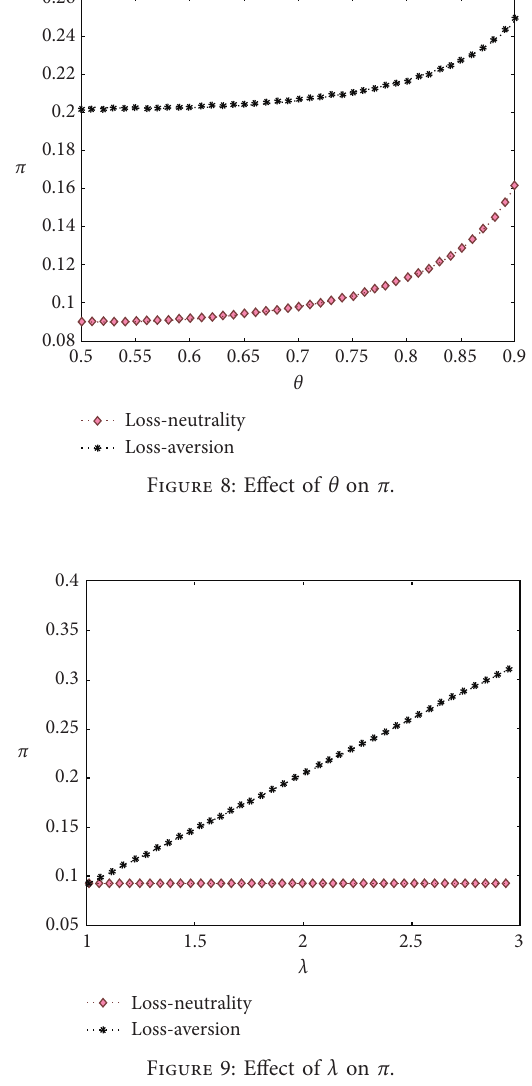
Figure 9: Effect of λ on π